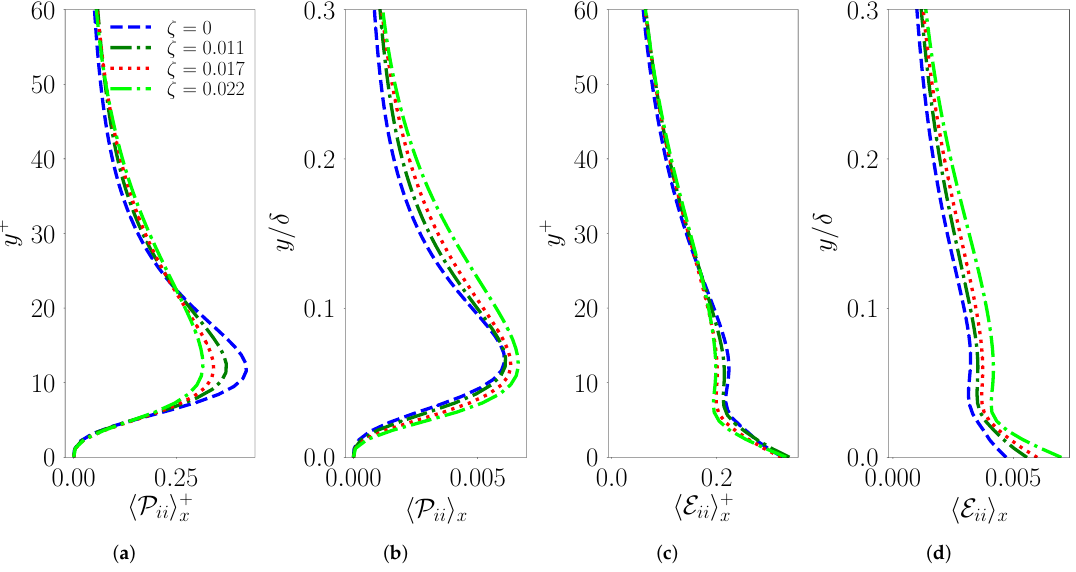
Figure 9. Schematic illustration of the wall-normal variation of streamwise averaged production of TKE in ( a ) inner variable nondimensionalized and ( b ) dimensional ( m 2 / s 3 ) forms. Corresponding nondimensional and dimensional forms of TKE dissipation are shown ( c , d